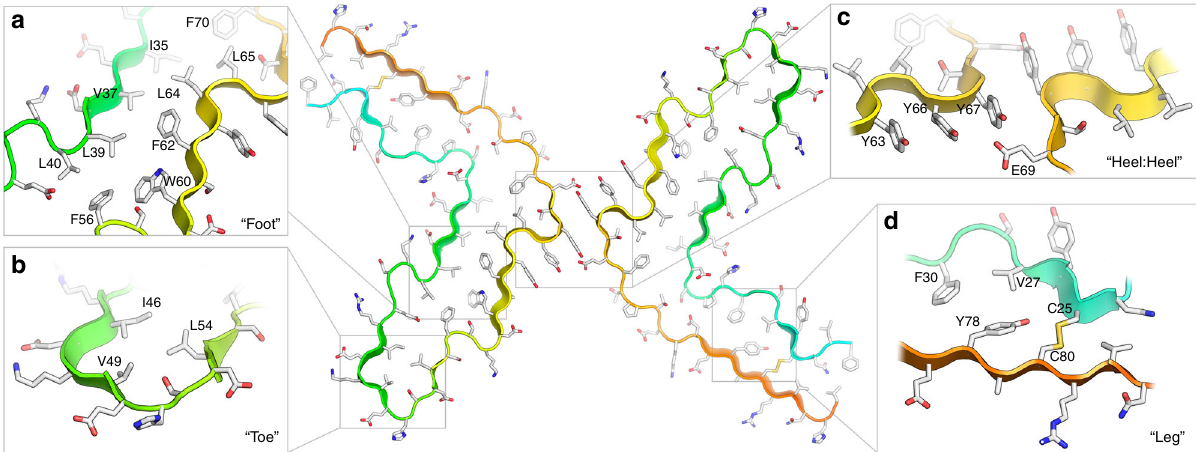
Fig. 5 The atomic model of a two proto fi lament β 2 m fi bril. The central panel shows two β 2 m subunits, and represents a cross-section through a layer of the EM reconstruction, perpendicular to the long fi bril axis. Each β 2 m subunit is L-shaped, stacked in register, perpendicular to the fi bril long (C 2 ) axis, and related by a 180° rotation about the C 2 axis (in the centre). The polypeptide is shown in cartoon representation, coloured from the N-terminus (i.e. M0 would be deep blue) to the C-terminus (M99 would be deep red). Side-chains are coloured in a CPK scheme. a A steric zipper in the foot; b a β -turn in the toe; c disul fi de-containing region; and d interface between proto fi laments showing π -stacking. See also Supplementary movie 2